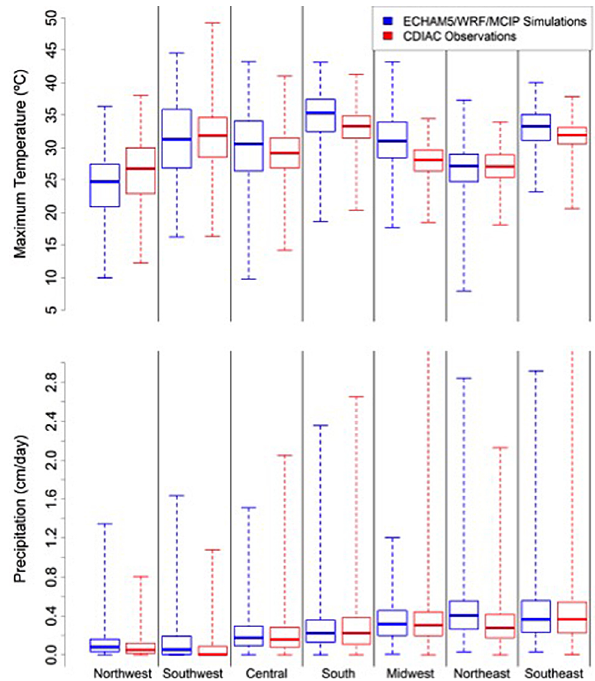
Figure 5. Comparison of modeled and observed seasonal-mean meteorological variables by region: maximum daily temperatures (top); and precipitation rates (bottom). Each box-and-whisker indi- cates median, 25 and 75% quartiles, maximums and minimums of the values across all sites within each